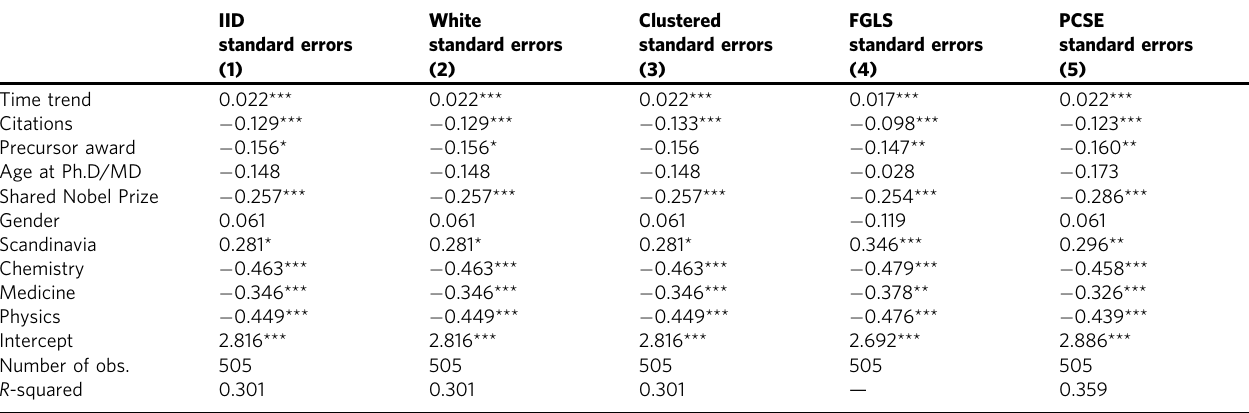
Table 6 presents calculations of Eq. (1) in fi ve different cases of model speci fi cation. In column (1) the error term is assumed to be identically and independently distributed (IID), while in column (2) is assumed that the error term is heteroscedastic and, therefore, the model is estimated withWhite robust standarderrors. In column (3) the error is assumed both heteroscedasticand serially correlated, whereas the model is calculated with clustered standard errors. In columns (4) and (5) is assumed the simultaneous presence of heteroscedasticity, serial and cross-sectional correlation and the estimations are made using feasible generalized least squares (FGLS) and panel-corrected standard errors (PCSE), respectively. Notice that columns (1 – 3) are almost identical to column (5) of Table